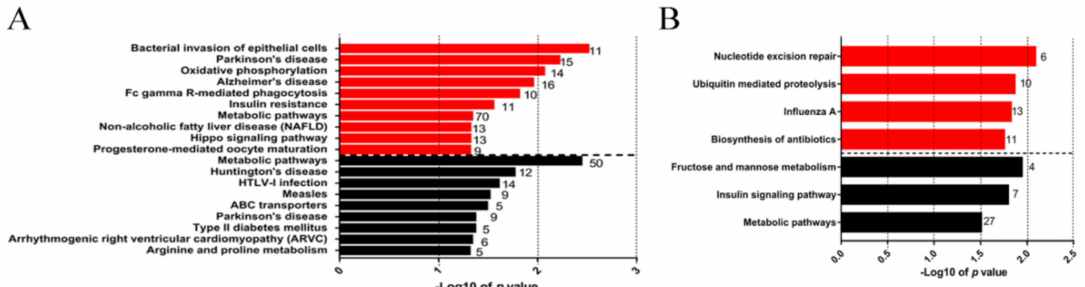
Figure 4. Kyoto Encyclopedia of Genes and Genomes pathways enriched with DEGs in peripheral blood mononuclear cells isolated from calves infected with di ff erent virulent M. bovis . ( A ) Pathways enriched with the up-regulated DEGs (red strips) and down-regulated DEGs (black strips) in P1 group versus mock-infected group; ( B ) Pathways enriched with the up-regulated DEGs (red strips) and down-regulated DEGs (black strips) in P150 group versus mock-infected group.